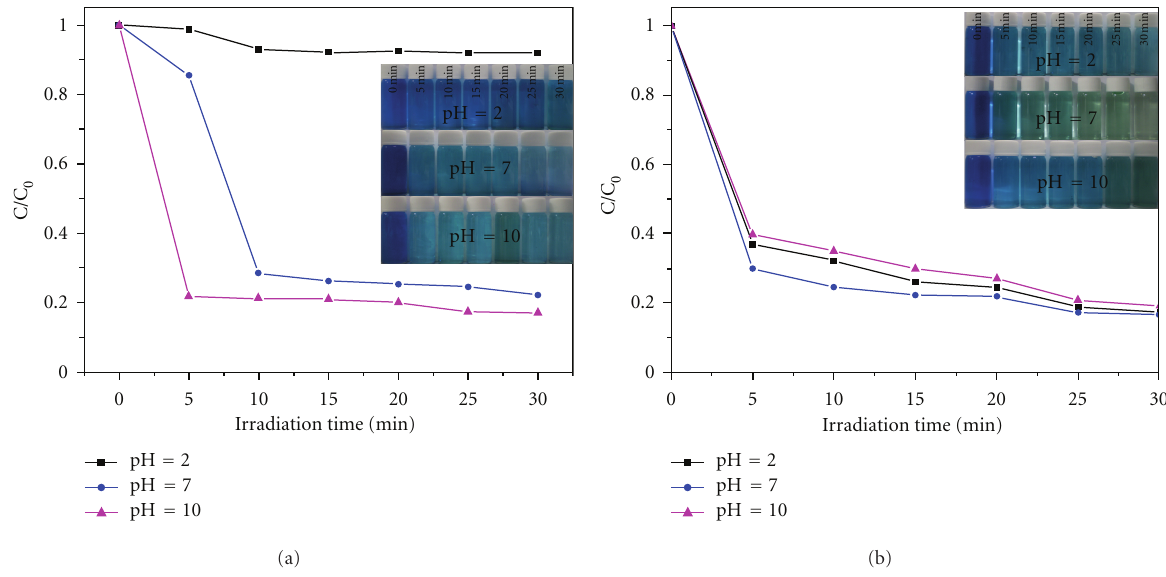
Figure 7: Photodegradation e ffi ciency of Fe 3 O 4 /SiO 2 /TiO 2 composite microspheres and digital illumination photographs at pH 2, 7, and 10 ((a) with 1 mL H 2 O; (b) with 1 mL H 2 O 2